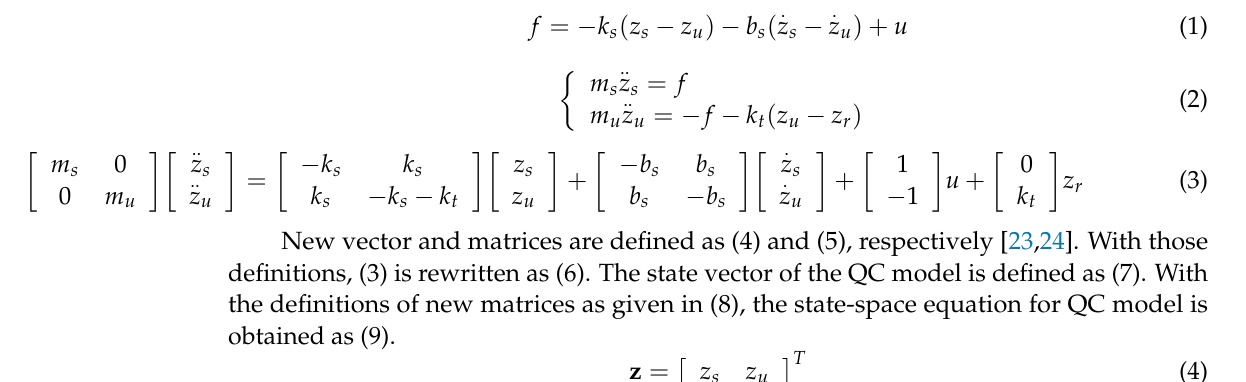
New vector and matrices are defined as (4) and (5), respectively [23,24]. With those definitions, (3) is rewritten as (6). The state vector of the QC model is defined as (7). With the definitions of new matrices as given in (8), the state-space equation for QC model is obtained as (9).